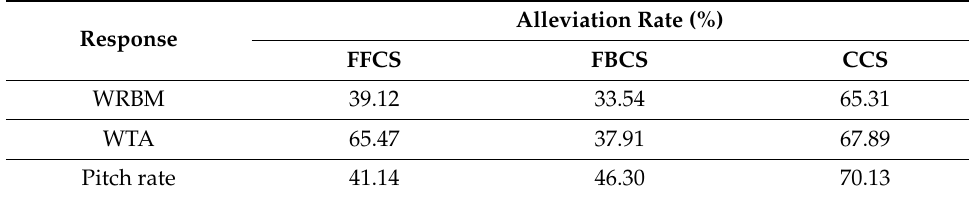
Table 3. Comparison of gust alleviation rates.